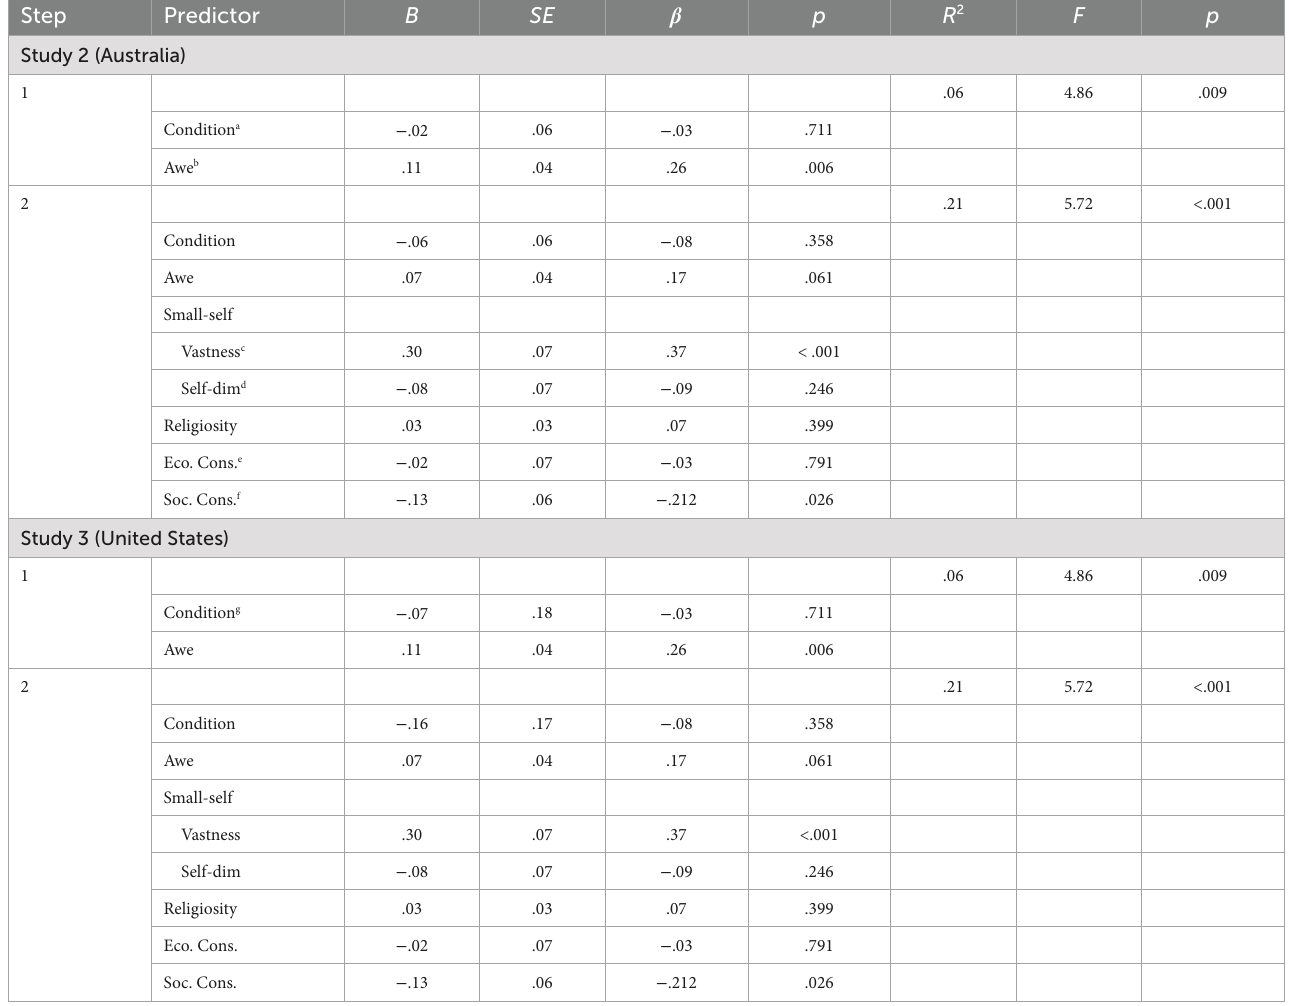
TABLE 3 Hierarchical linear regression of condition (awe vs. control), awe, and small-self (‘vastness vis-à-vis the self’ and self-diminishment) predicting levels of moral expansiveness in Studies 2 and 3.